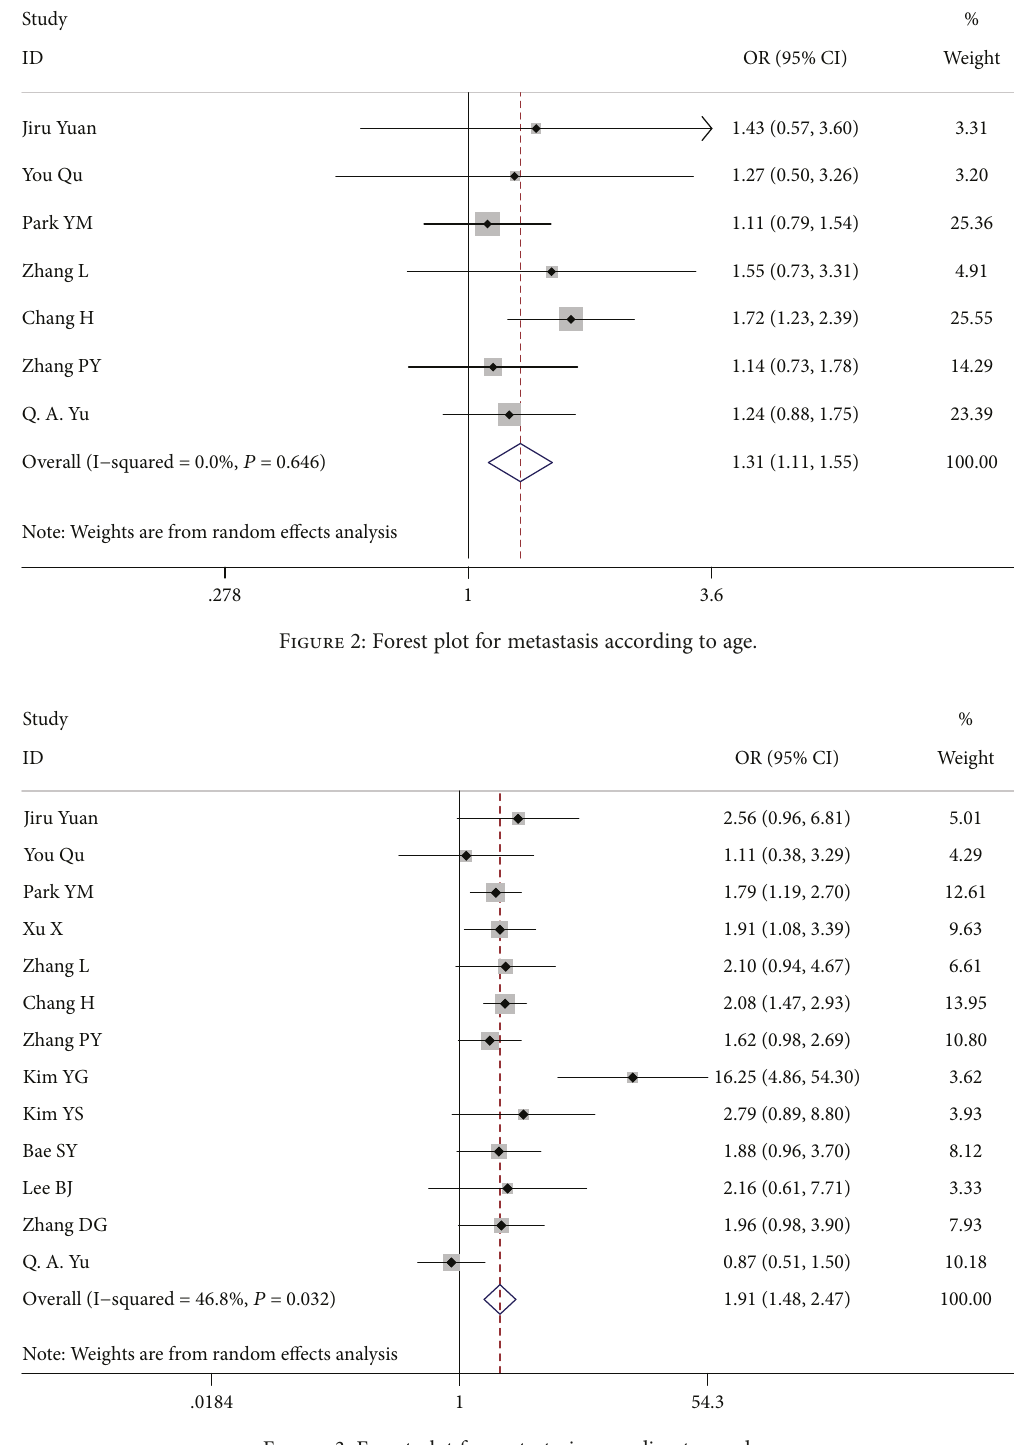
Figure 3: Forest plot for metastasis according to